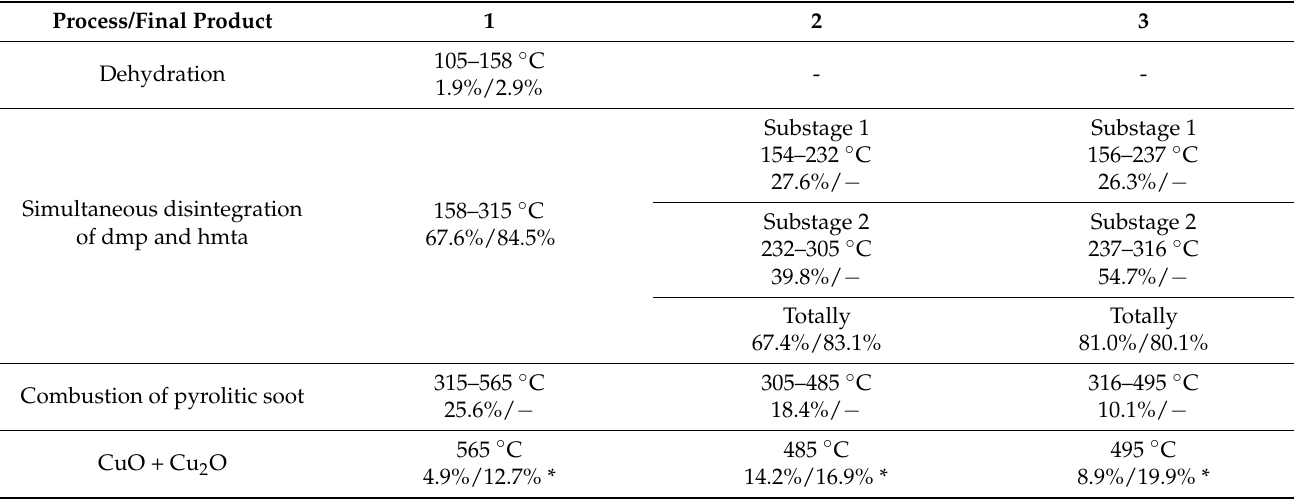
Table 5. Temperature ranges and mass losses (experimental/theoretical) of thermal decomposition